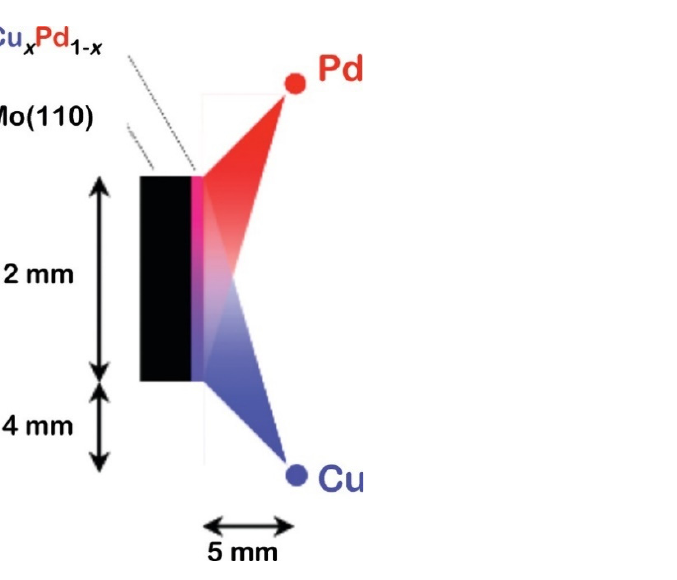
Figure 1. Schematic diagram of the evaporation geometry used for preparing Cu x Pd 1–x Composition Spread Alloy Films (CSAFs). The Pd and Cu evaporative line sources (normal to the plane of the figure) are offset from the center of the Mo (110) substrate but are close enough to create a gradient in flux across the substrate’s surface. Reproduced with permission from [14]. Copyright © 2011, American Chemical Society.